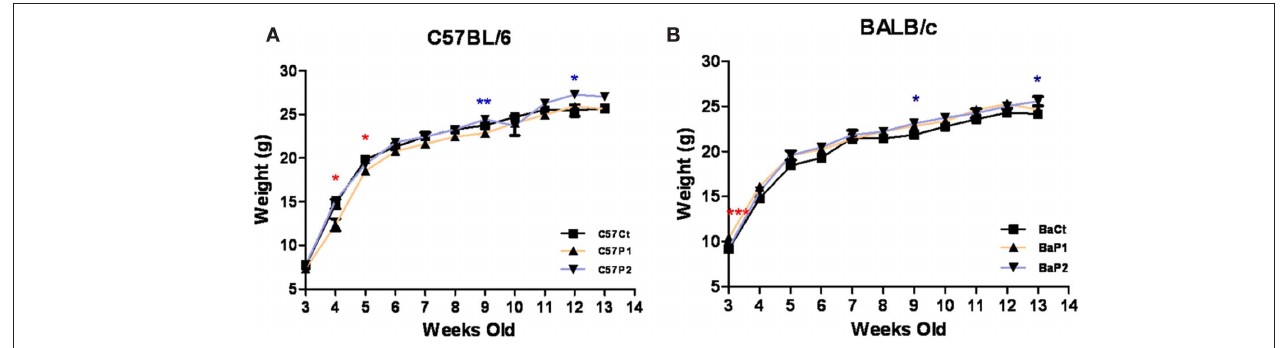
Figure 2 | effect of MS on bodyweight evolution. MS had an overall effect in C57BL/6 (A) , but not BALB/c (B) mice, over time, although protocol differences only rose for an isolated time-point, at 4 weeks old (C57BL/6 protocol